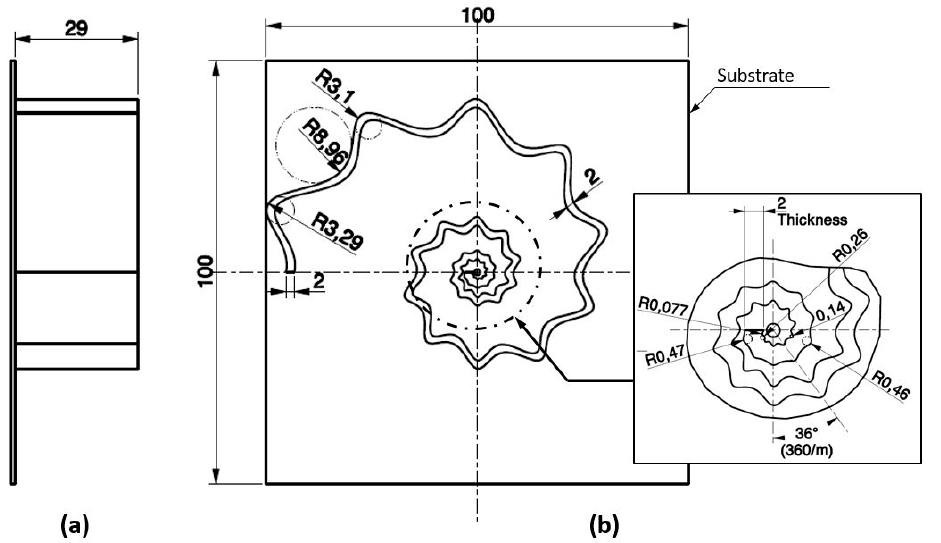
Figure 2. ( a ) Side view and ( b ) top view with main dimensions and rounds radii R (inset) related to the spiral shell DRA (SsDRA).